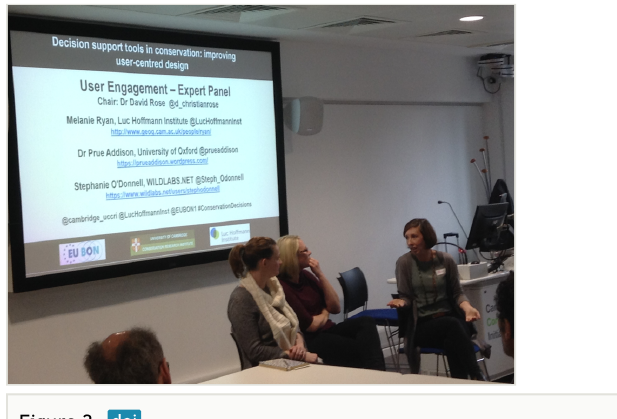
Panel session on user engagement. From Left: Melanie Ryan (Luc Ho ff mann Institute), Stephanie O’ Donnell (WILDABS.NET, FFI), Dr Prue Addison (University of